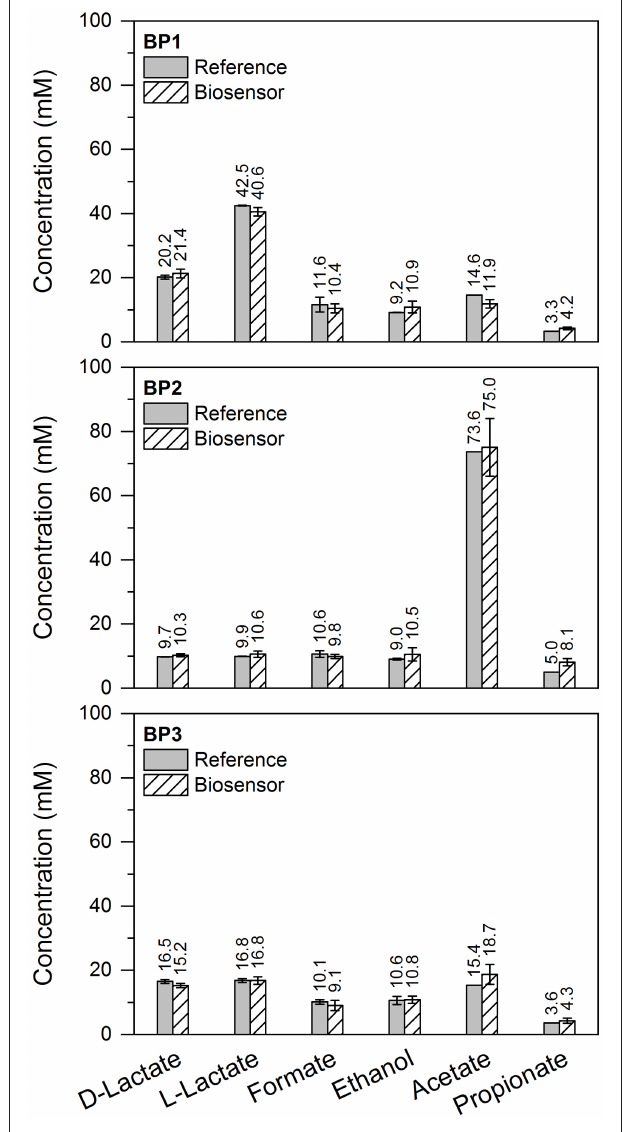
FIGURE 5 | Comparison between the results obtained by the two biosensors and the corresponding reference technique. Samples were collected from three different biogas plants (BP1, BP2, BP3) and spiked with 20 mM acetate, 5 mM propionate and 10 mM ethanol, formate, D - and L -lactate. For detection of ethanol, formate, D - and L -lactate a photometric reference technique was applied, and acetate and propionate were additionally quantified by gas